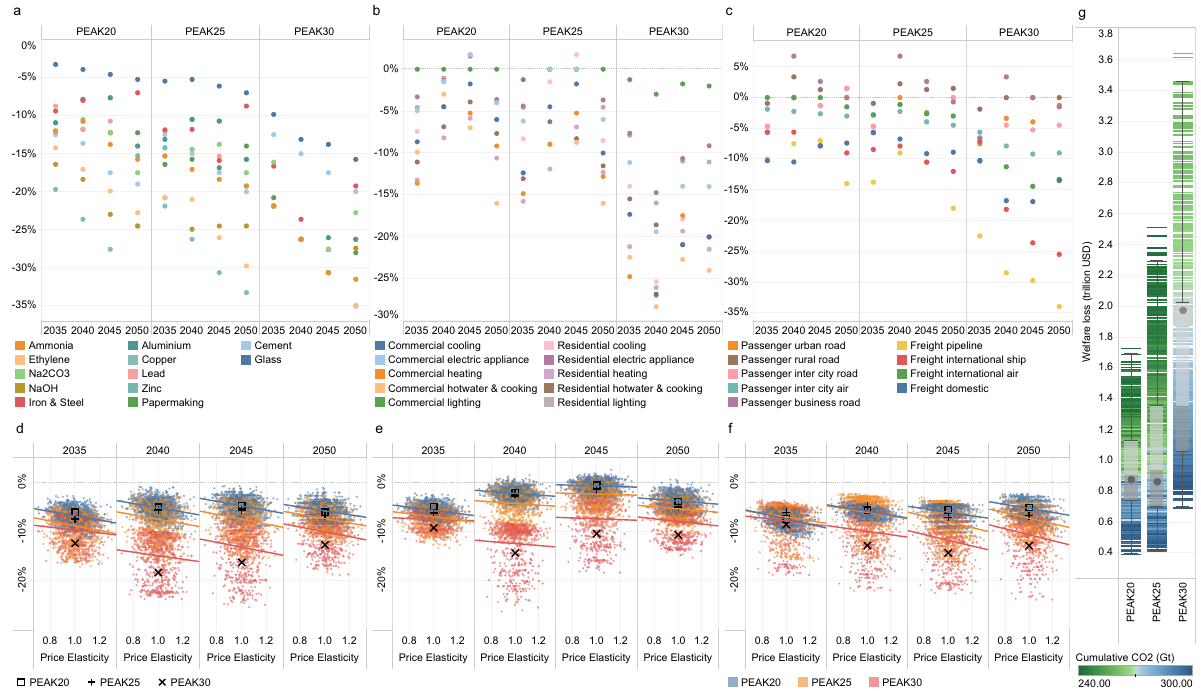
Fig. 6 Graphic of the impact of mitigation on producer and consumer behaviors for the intermediate case in each scenario. a – c show the declines in the rate of energy service demand for the industry, building, and transport sectors due to price elasticity relative to the NDC scenario, respectively. d – f represent the relationship between the energy service demand for the industry, building, and transport sectors and uncertain price elasticity, respectively. The intermediate cases of PEAK20, PEAK25, and PEAK30 are denoted with square, plus, and multiplication signs, respectively. g summarizes the total discounted welfare loss relative to the value in the NDC scenario for 2020 – 2050 (unit: trillion US dollar). The black points in panel g denote the welfare loss for the intermediate case in each scenario. The box plot shows the fi rst quantile, intermediate range (IQR), and third quantile of all the results, where the data range within 1.5 times the IQR is denoted with whiskers. The divergent color from blue to green re fl ects the increasing stringency of the cumulative carbon budget. The cumulative CO 2 parameter corresponds to the absolute value of China ’ s cumulative carbon budget for 2010 – 2050. Na 2 CO 3 sodium carbonate, NaOH sodium